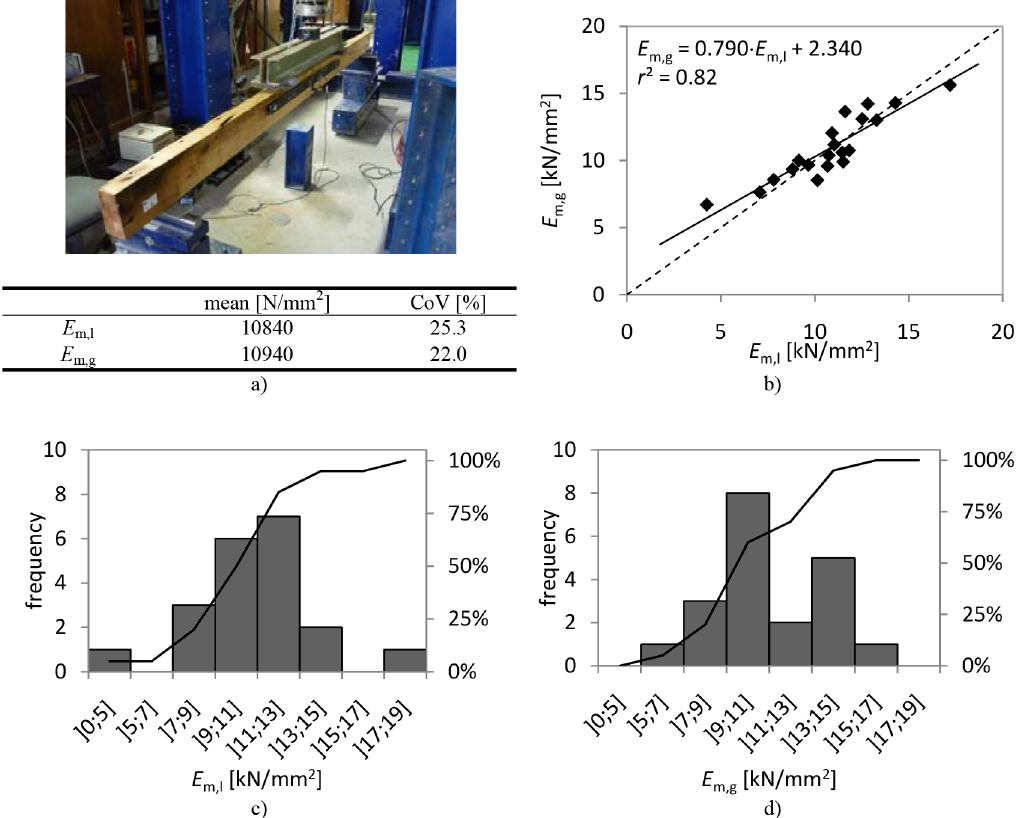
Fig. 6. Sawn beams bending tests in elastic regime: a) test set-up and results; b) correlation between E m,l and E m,g ; c) histogram and cumulative distribution function for E m,l ; d) histogram and cumulative distribution function for E